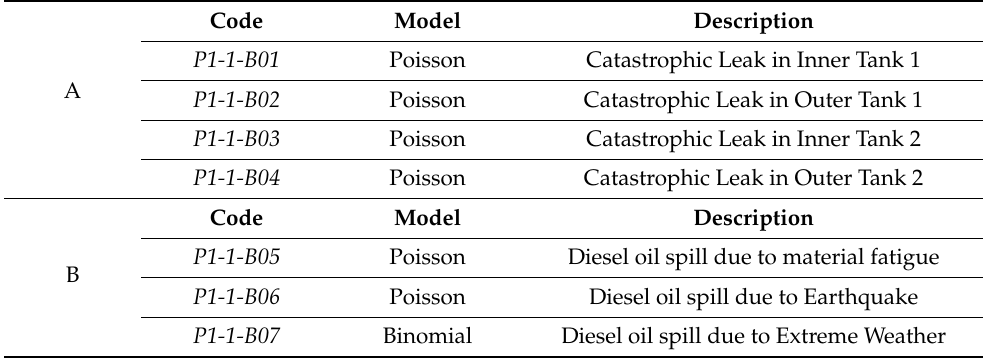
Table 2. Description and probabilistic models for BEs of FT2 (A) and FT1